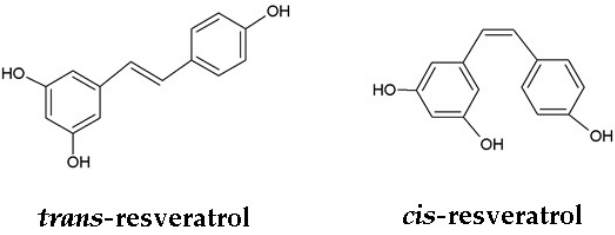
(cid:48) -trihydroxystilbene)